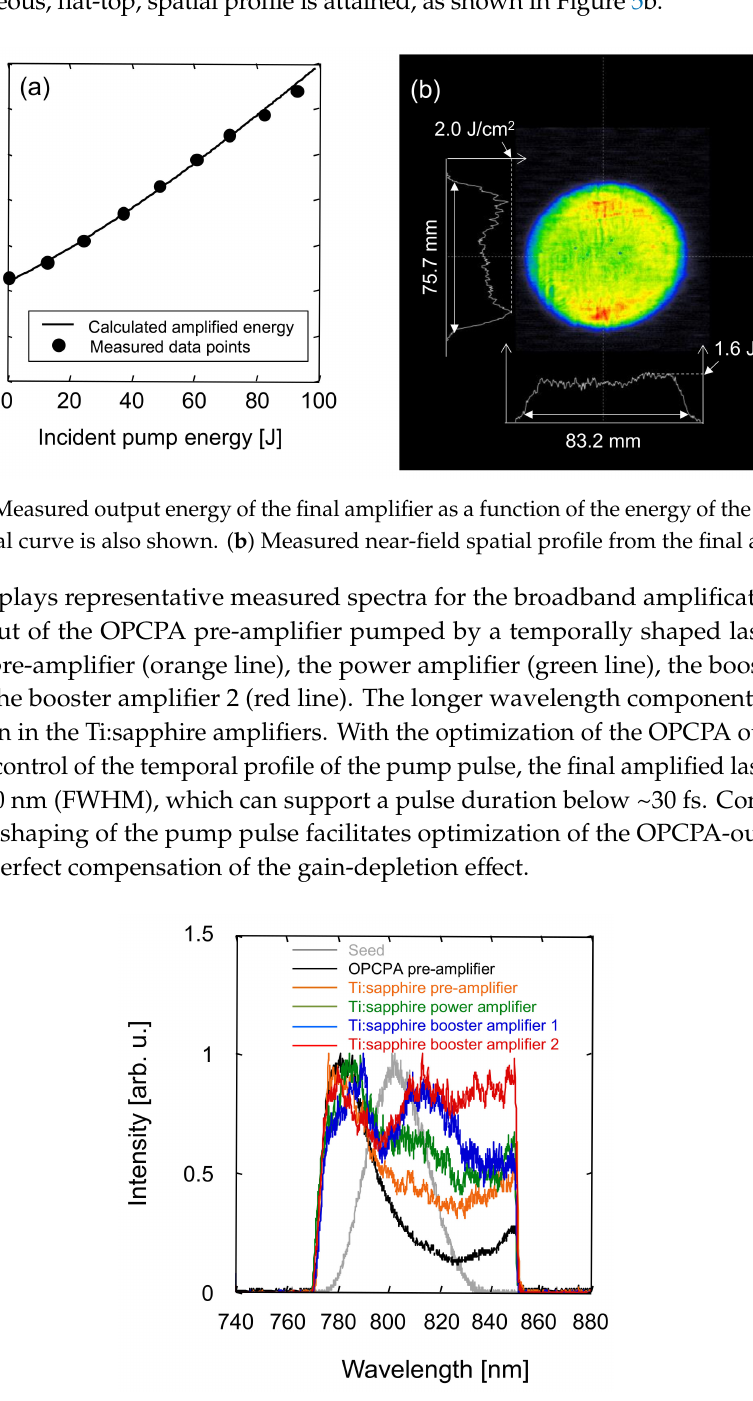
Figure 6. Representative measured spectra for the broadband amplification of the seed (gray line), output of the OPCPA pre-amplifier pumped by a temporally shaped laser (black line), the Ti:sapphire pre-amplifier (orange line), the power amplifier (green line), the booster amplifier 1 (blue line), and the booster amplifier 2 (red